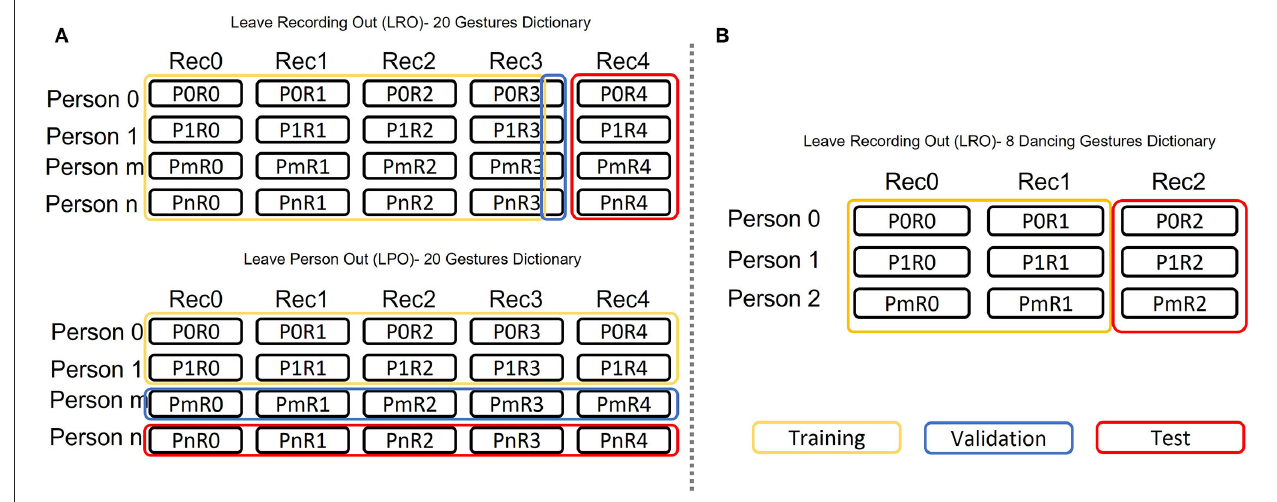
FIGURE 4 | Data partition scheme to train and test the deep learning models. (A) Shows the Leave-recording out (LRO) and Leave-person out (LPO) paradigms used for the data of the 20 general postures. (B) Shows the Leave-recording out (LRO) scheme employed for the data of the eight dance